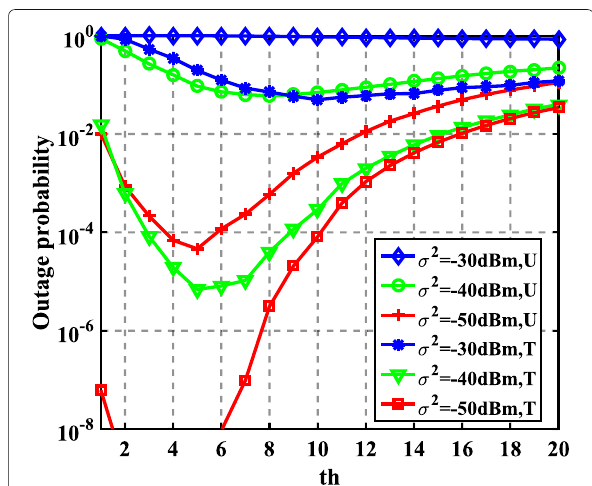
Fig. 6 Outage probability vs. K with different SUs’ capacity